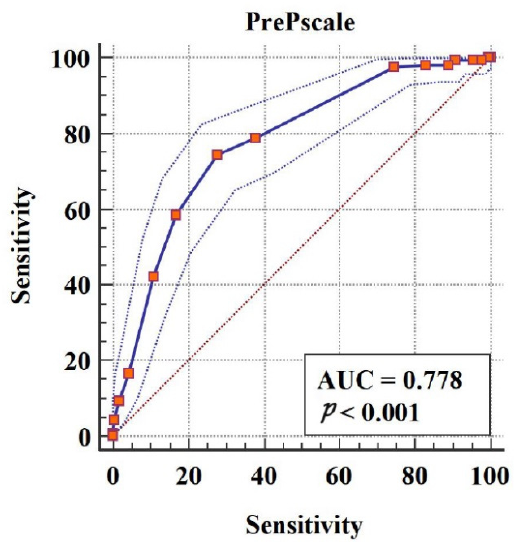
Figure 1. Receiver operating characteristic curve analysis of pre-exposure prophylaxis (PrEP) adher-